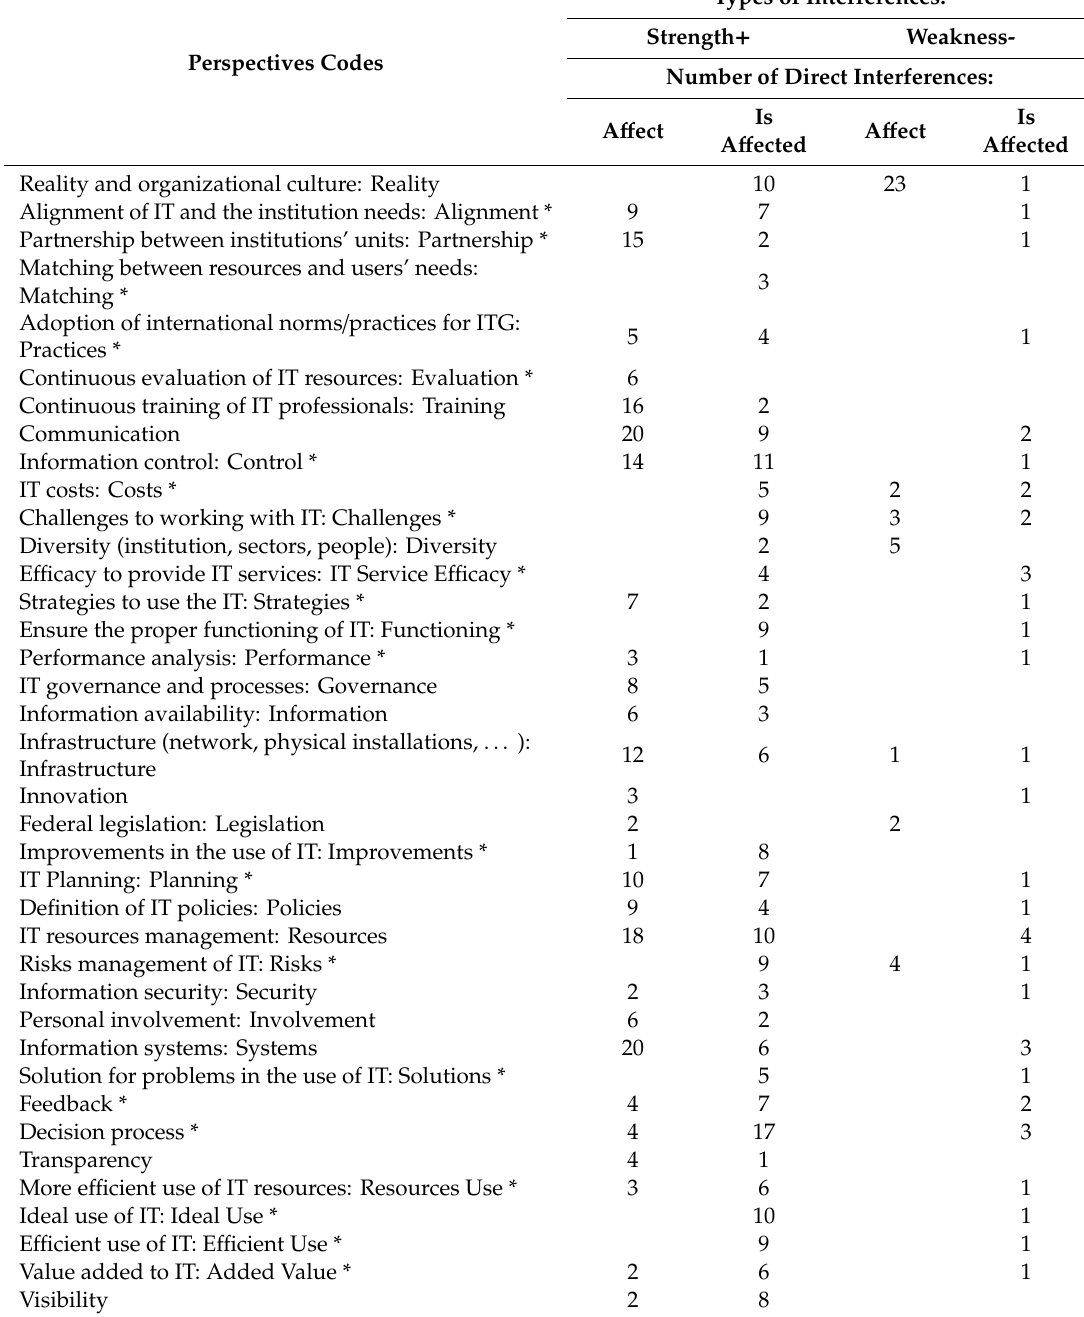
Table 3. Perspectives and